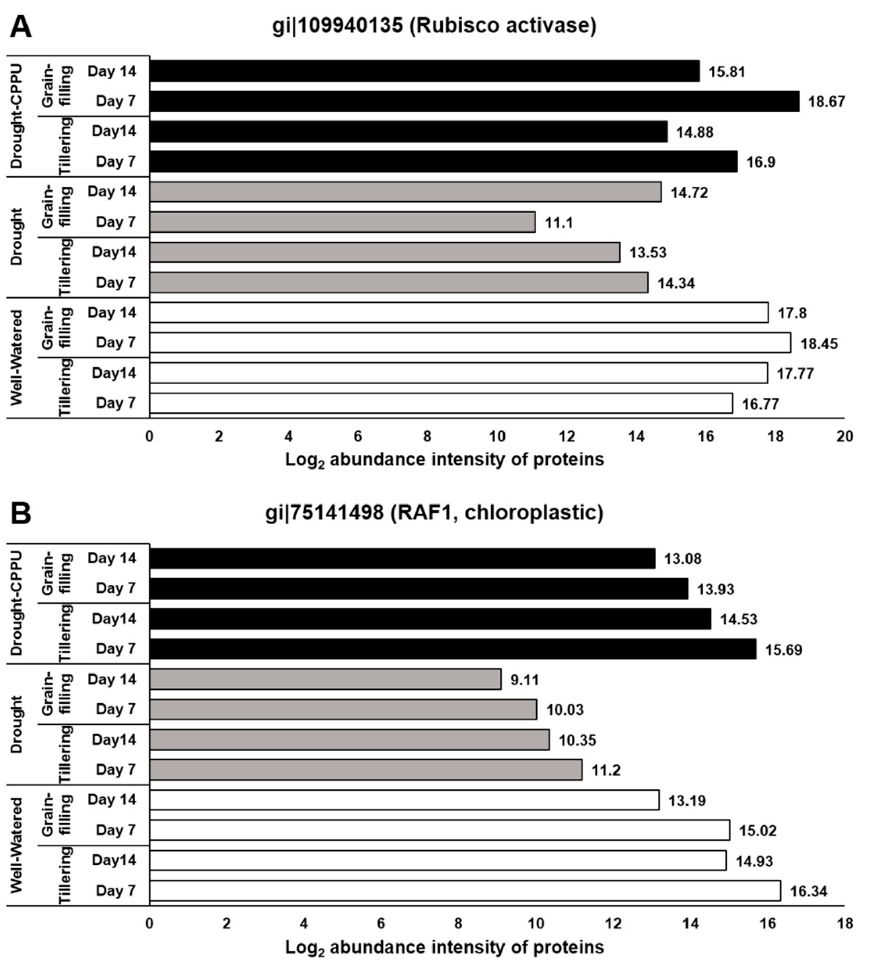
Figure 10. The influence of synthetic cytokinin and drought on the abundance intensities of ( A ) Ribulose bisphos carbo / oxygenase (Rubisco) activase and ( B ) Rubisco accumulation factor (Raf) 1 proteins involved in the regulation and functioning of Rubisco at the tillering and grain-filling stages of the rice. Protein abundance intensities, represented on the X- axis, are the highest log2 fold change values of technical replicates. [Well-Watered plants were maintained at a soil moisture tension of − 15 kPa during the treatment period. Drought stress was imposed by withholding water for up to 14 days. Soil moisture tensions of − 55 kPa and − 72 kPa were recorded at day 7 and day 14 during the treatment, respectively. CPPU treatment was given by foliar spraying plants with a 5 mg / L solution of CPPU at the rate of 25 mL / plant on day 6 of drought